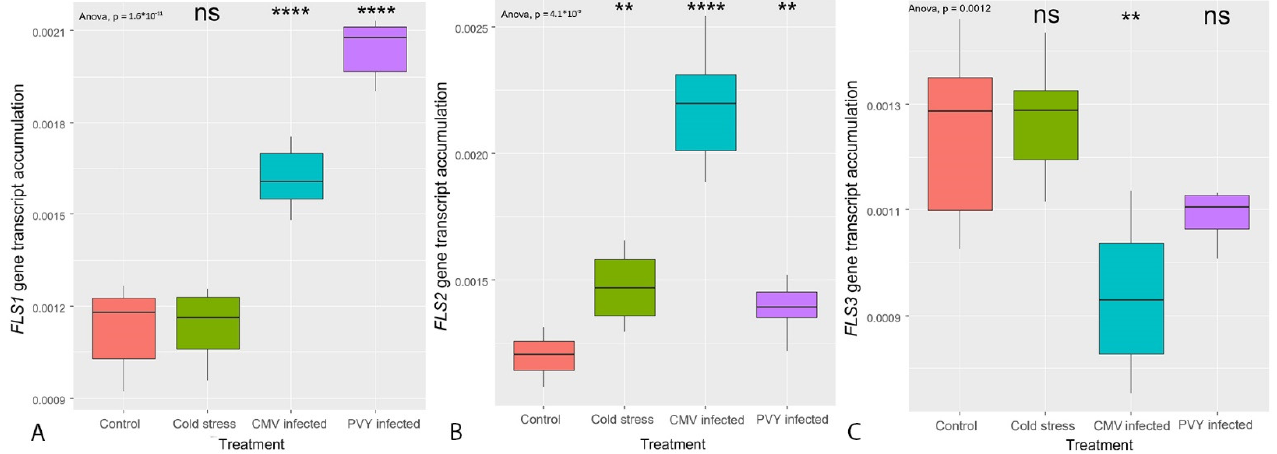
Figure 6. Transcription of the genes encoding for flavonol synthase (FLS) isoenzymes of tomato leaves (cv. Elpida) ( A ): FLS1 , ( B ): FLS2, ( C ): FLS3 ) following plant exposure to cold stress (5 °C for 16 h) or inoculation (20 d) with either cucumber mosaic virus ( CMV ) or potato virus Y ( PVY ). Significant differences were determined by one-way ANOVA comparisons ( p ≤ 5%). Signif. codes: ns: non-significant; 0.05: *; 0.01: **; 0.001: ***; 0: ****.